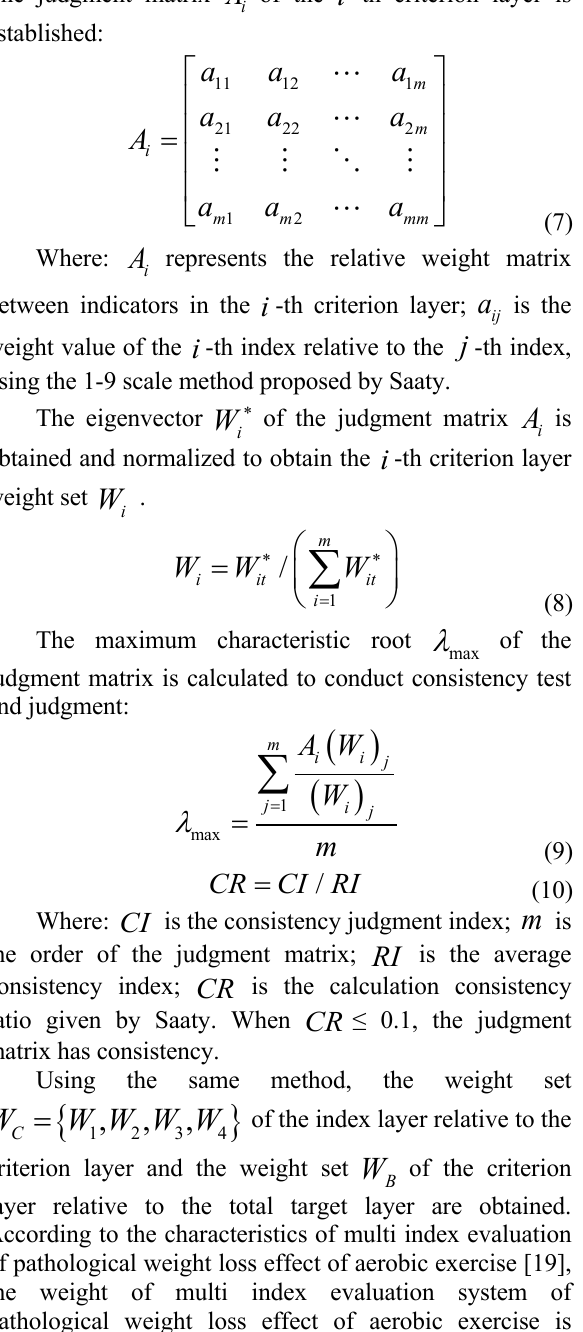
Table 2. Weights of indicators of pathological